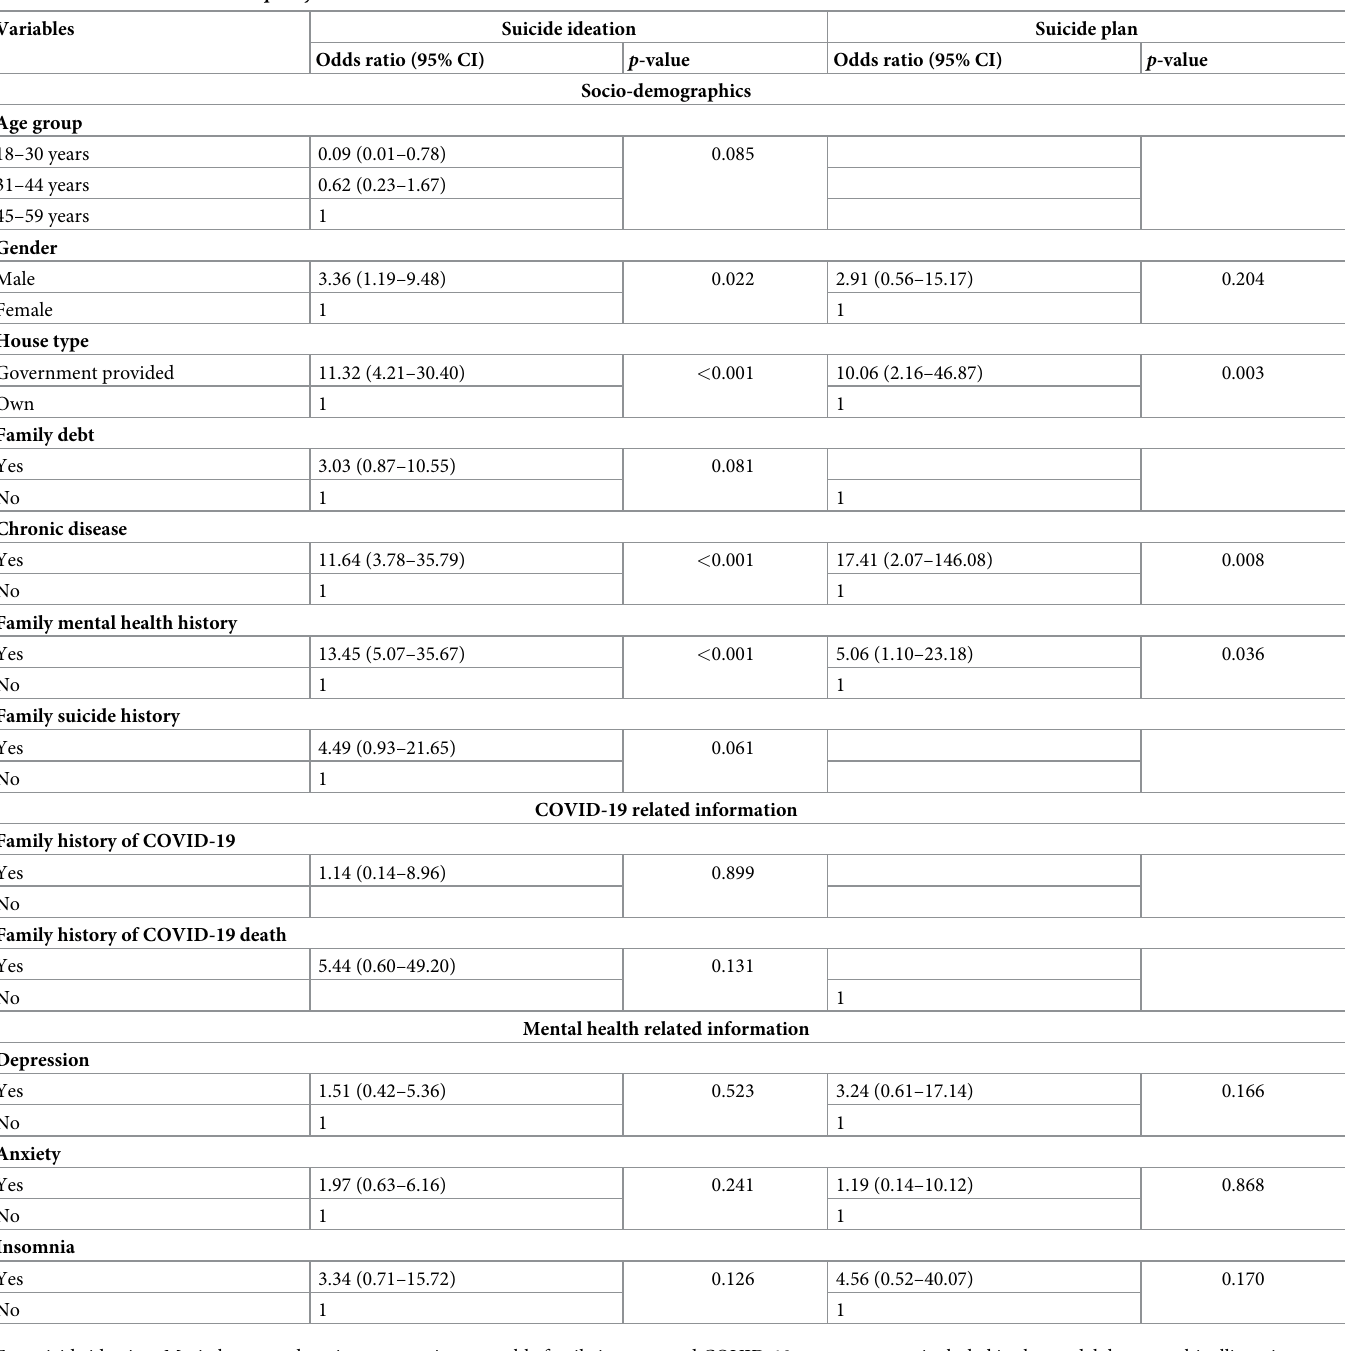
Table 6. Factors associated with past-year suicide